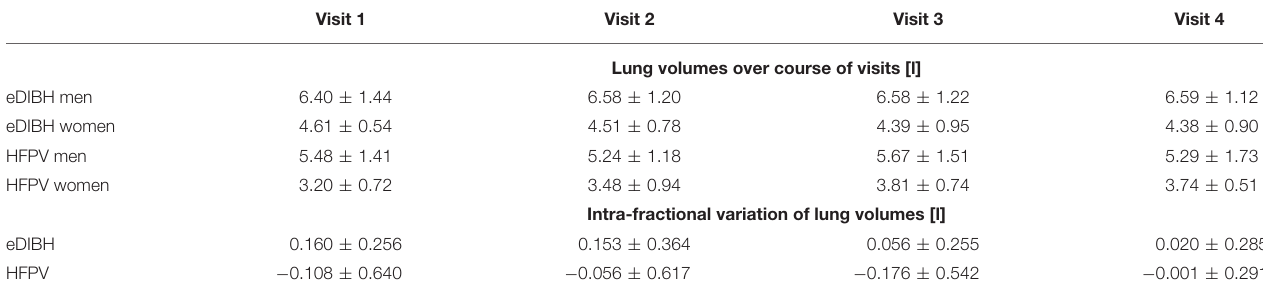
TABLE 2 | All data presented in [l] as mean ± SD. Visit 1 Visit 2 Visit 3